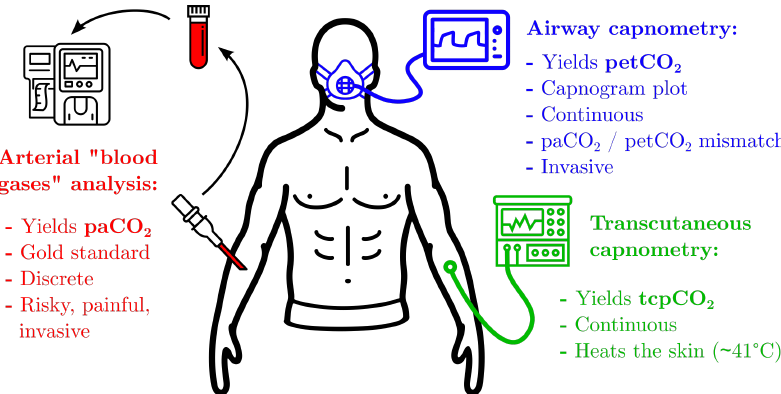
Figure 12. The three in vivo CO 2 probing modalities and their key